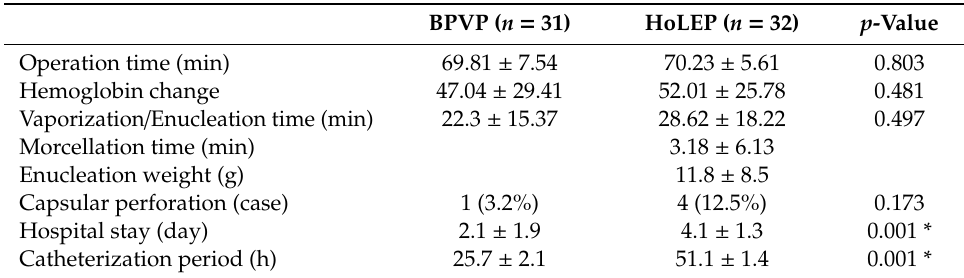
Table 2. Perioperative and postoperative results of BPVP and HoLEP group.